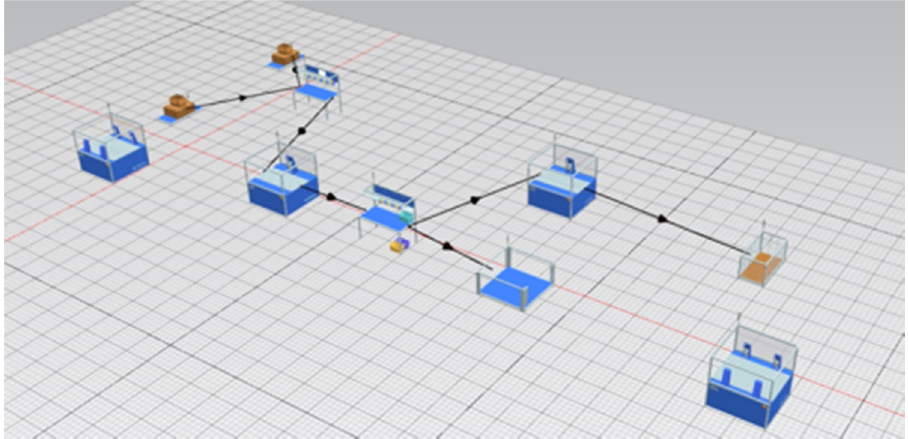
Figure 7: The basic model in 3 - D